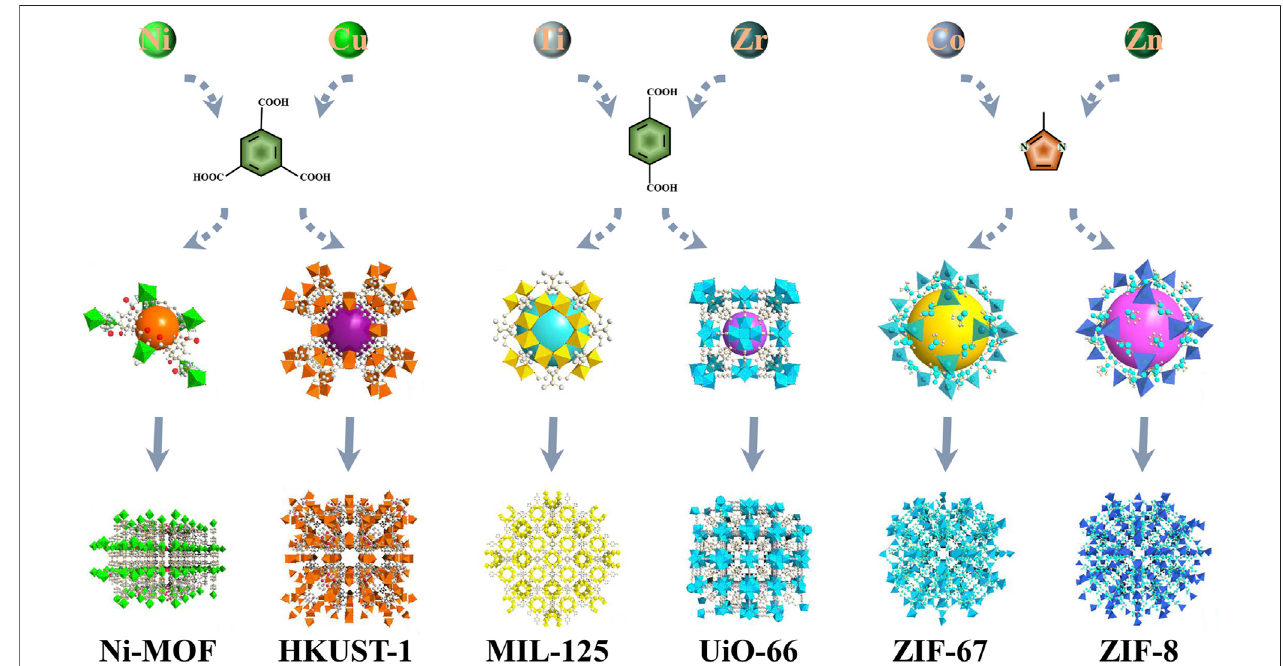
FIGURE 3 | MOFs with various skeleton structures fabricated utilizing different metal ions and organic